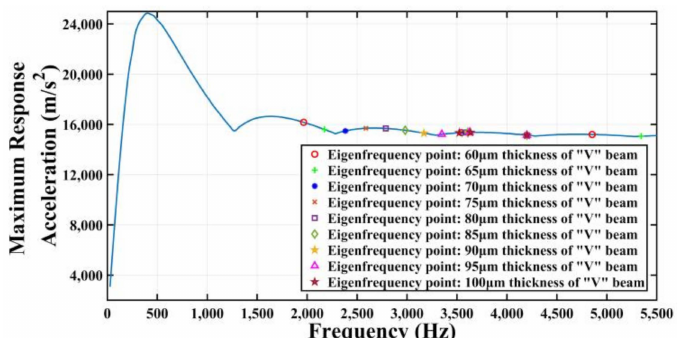
Figure 14. The shock response spectrum of half-cycle sine shock pulse (amplitude is 1500 g and duration is 2 ms) and the frequency points in Table